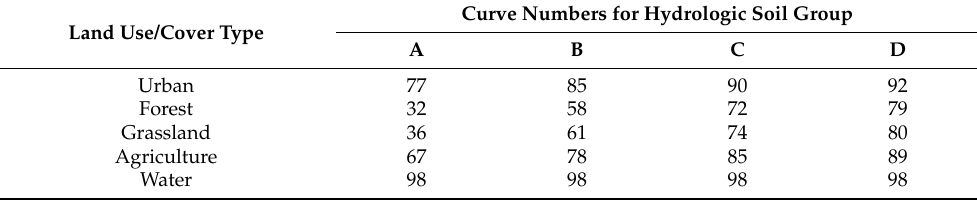
Figure 3. Spatial distribution of hourly rainfall in the study catchment, ( a ) Rainstorm 1, ( b ) Rainstorm 2, and ( c ) Rainstorm 3. Table 2. LULC types and corresponding CN values for each hydrologic soil group used in the present